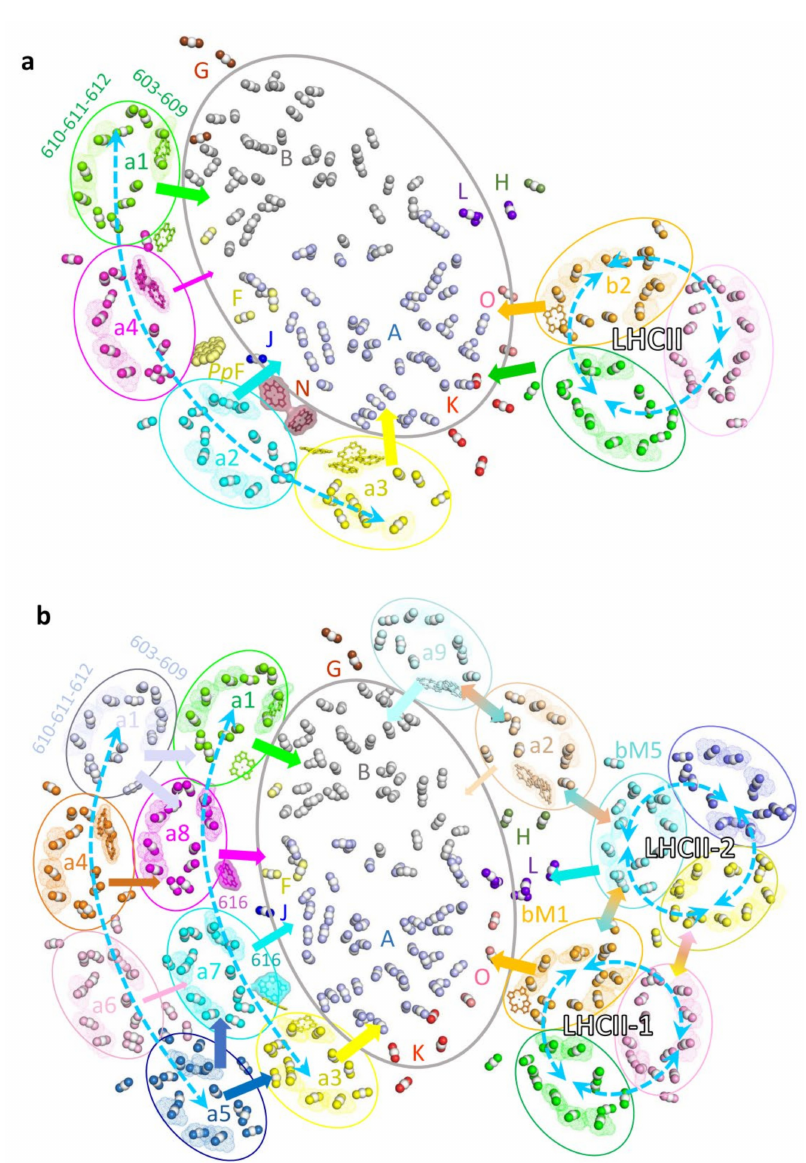
Figure 4. Pigment arrangement and potential energy transfer pathways in the PSI–LHCI–LHCII supercomplexes from land plants and green algae. ( a ), Energy transfer pathways within Zm PSI– LHCI–LHCII. ( b ), Energy transfer pathways within Cr PSI–LHCI–LHCII. The chlorophyll molecules are simplified with a central Mg and two nitrogen atoms in the sphere mode. All Mg atoms are shown in white, and the nitrogen atoms are shown in the same color as their belonging subunits in Figures 2 and 3. The Chl clusters 610-611-612 and 603-609 in each LHC protein are highlighted with dots. The red Chl pairs in Zm Lhca3, Zm Lhca4 and C rLhca2, Cr Lhca4 and Cr Lhca9 are shown as sticks and dots. Specific Chls located in the Lhca–core gap region in the Zm PSI–LHCI–LHCII and Cr PSI–LHCI–LHCII structures, namely, two Chls from Zm PsaN and Chls 616 from Cr Lhca7 and Cr Lhca8, are displayed as surfaces and sticks. One Chl from Pp PsaF located between the core and the middle Lhcas in P. patens is displayed as spheres. The special Chls which regulate the energy transfer from the antenna to the core on the luminal side are displayed as sticks, including Chls 607 and 617 in Lhca3, Chls 607 and 616 in Lhca1, Chl 614 in Zm Lhcb2 and Cr